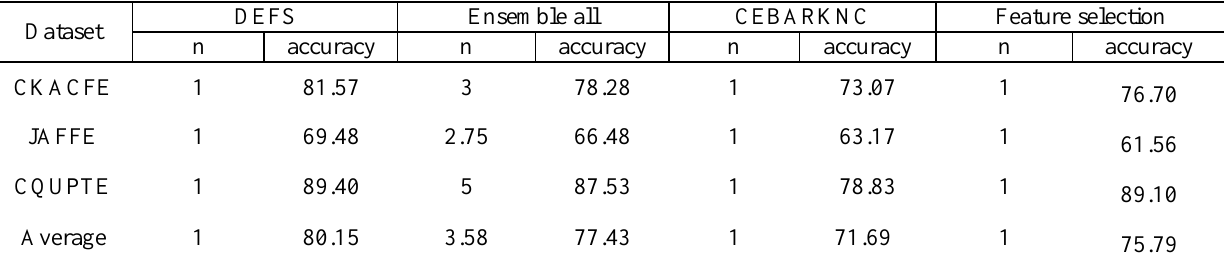
Table 3 Results of the comparative